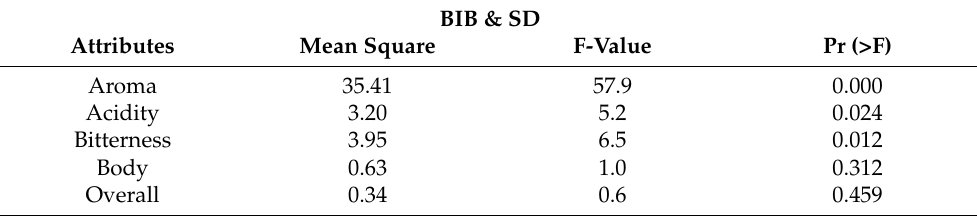
Table 1. Comparison for sensory attributes evaluated in CLCs without additive (BIB) and with additive (SD at the initial time by ANOVA.